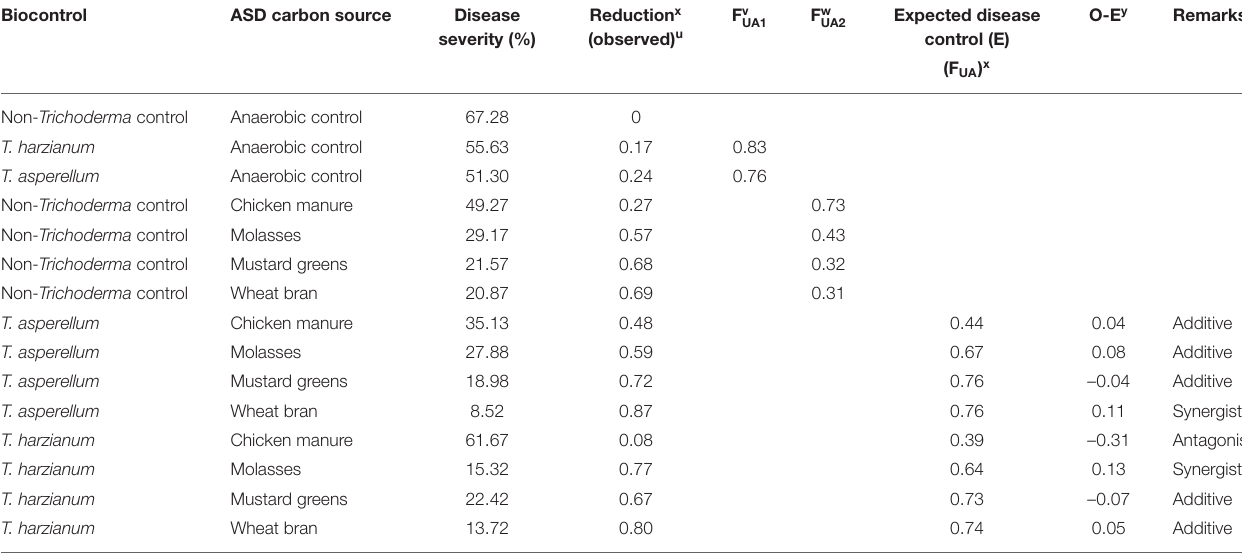
TABLE 3 | Synergy and additivity analysis using the Bliss independence model between carbon source and Trichoderma spp. amendments in suppression of Rhizoctonia root rot in radish plants grown in anaerobic soil disinfestation (ASD)-treated soil. Biocontrol ASD carbon source Disease Reduction x severity (%) (observed)